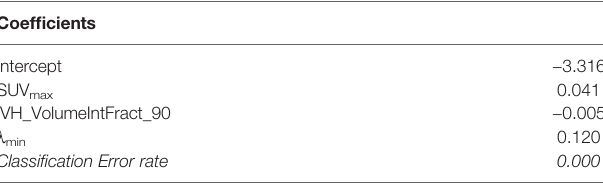
TABLE 4 | Coef fi cients, tuning parameters, and classi fi cation error rate for the two LASSO logistic models for radiological PET response (26). Coef fi cients Intercept − 3.316